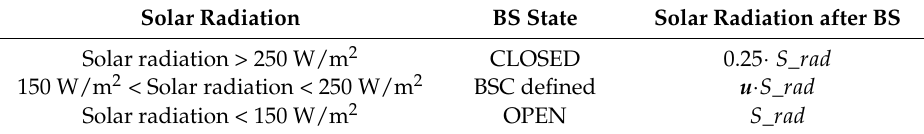
Table 4. BS state related to the incident solar radiation ( S_rad ) and solar radiation value through